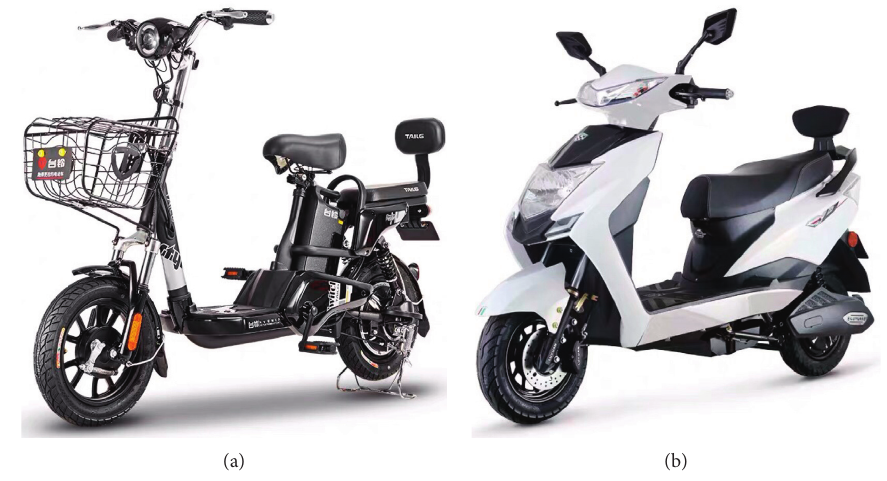
Figure 3: (a) Bicycle-style e-bike. (b) Scooter-style e-bike.